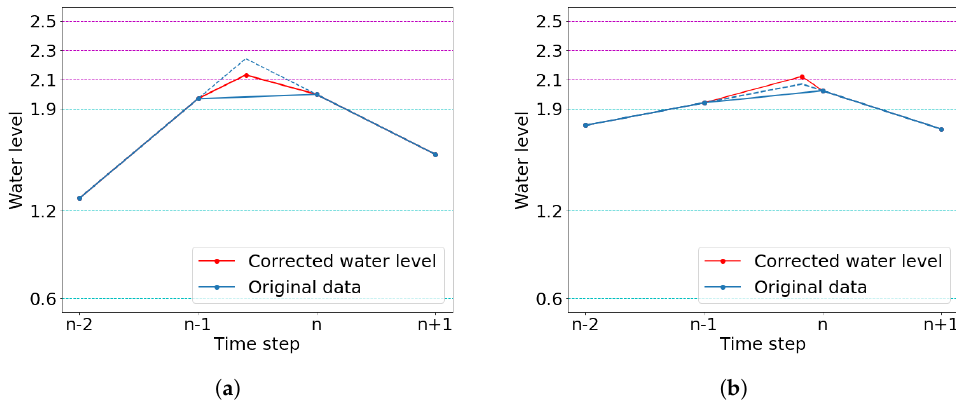
Figure 5. Two sub-cases of case B1. ( a ) Illustration of sub-case B1 (iii): f n − 1 = 1.968 and f n = 1.997 (with f n − 2 = 1.286 and f n + 1 = 1.587). ( b ) Illustration of sub-case B1 (iv): f n − 1 = 1.94 and f n = 2.01 (with f n − 2 = 1.785 and f n + 1 = 1.76).